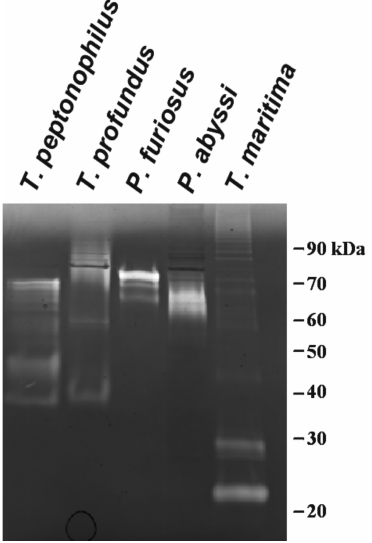
Figure 3. Extracellular proteolytic inventory from various hyper- thermophiles. Pyrococcus furiosus and P. abyssi were grown at 95 °C, and T. profundus , T. peptonophilis and Thermotoga maritima were grown at 80 °C. The cells were removed after 14 h of growth and the extracellular enzymes were precipitated by addition of ammonium sulfate to 80%. Two µg of total extracellularprotein was loaded onto a 12% SDS-polyacrylamide gel containing